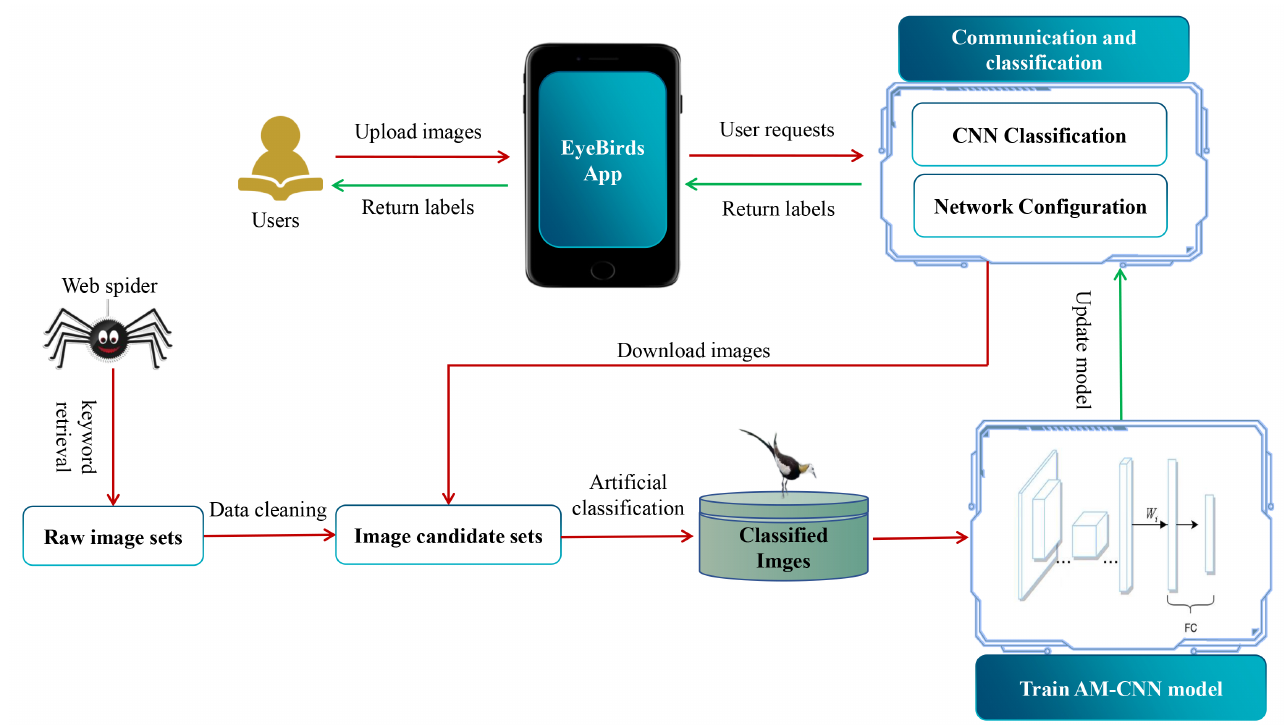
Figure 1. The architecture of the Eyebirds